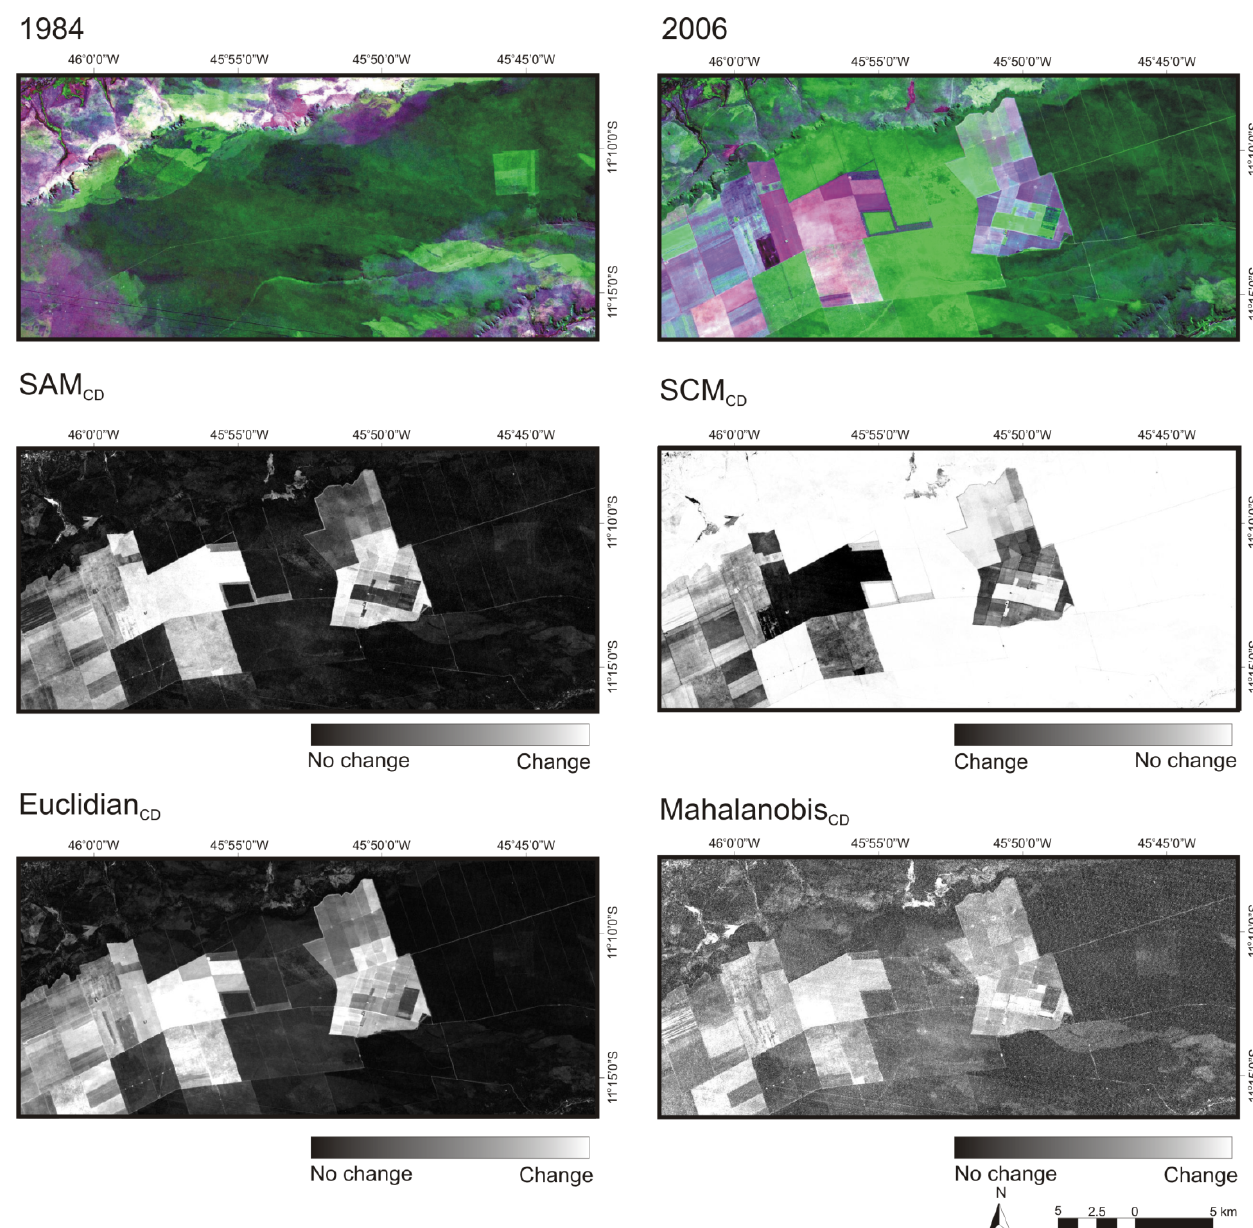
Figure 7. Images resulting from the change-detection (CD) methods. (a) 1984 input image; (b) 2006 input image; (c) Spectral Angle Mapper (SAM Mapper (SCM ); (e) Euclidian distance; and (f) Mahalanobis CD